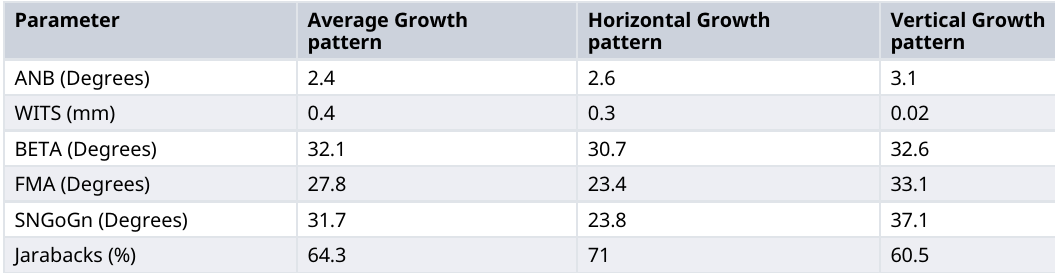
Table 9. Average values for all parameters in all 3